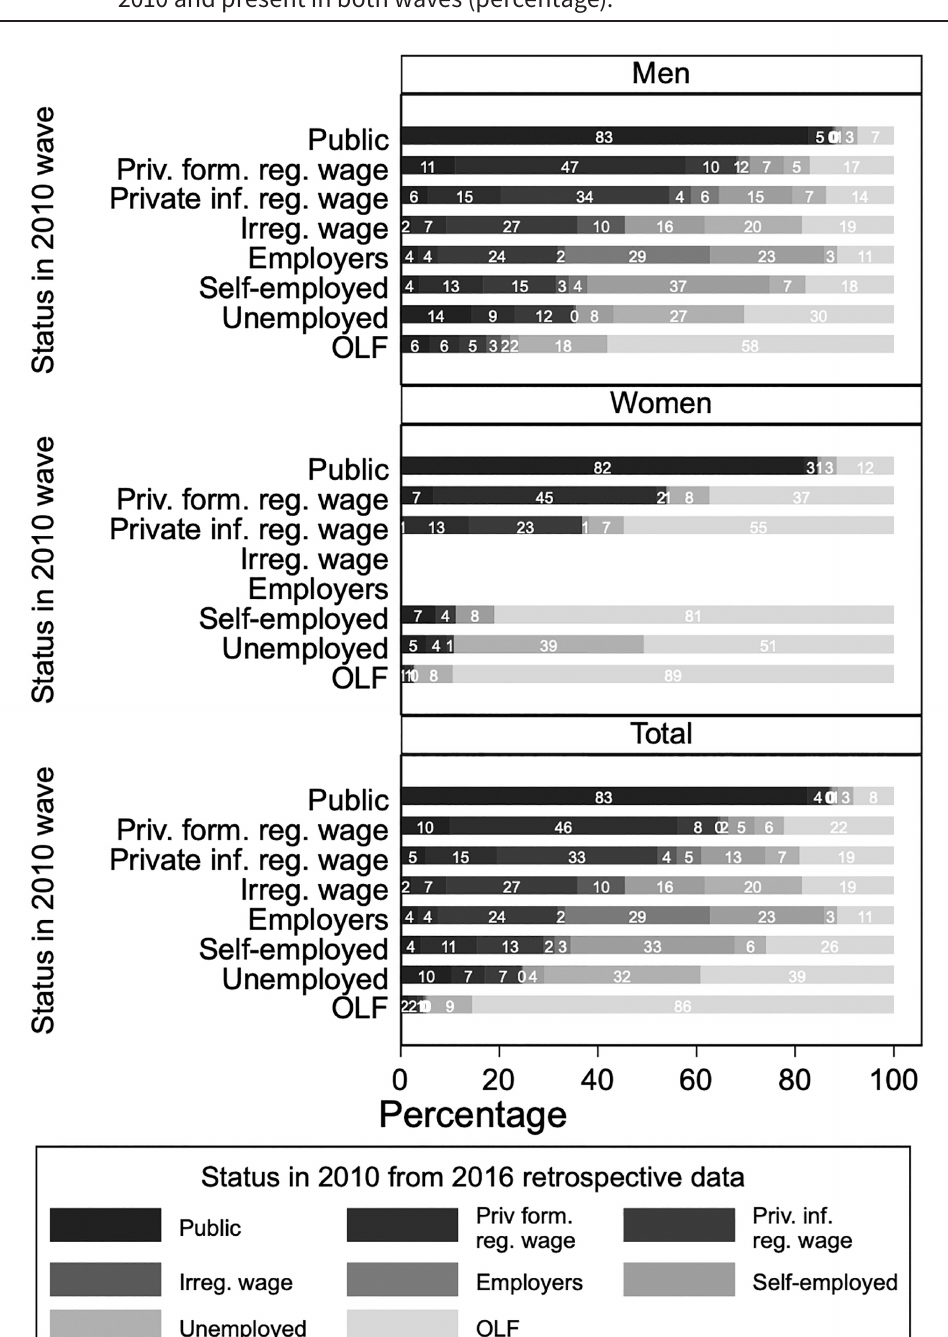
Figure 10 . Labor market status, as reported retrospectively for 2010 from 2016 data, by sex and contemporaneous status for 2010, individuals aged 20–44 years in 2010 and present in both waves